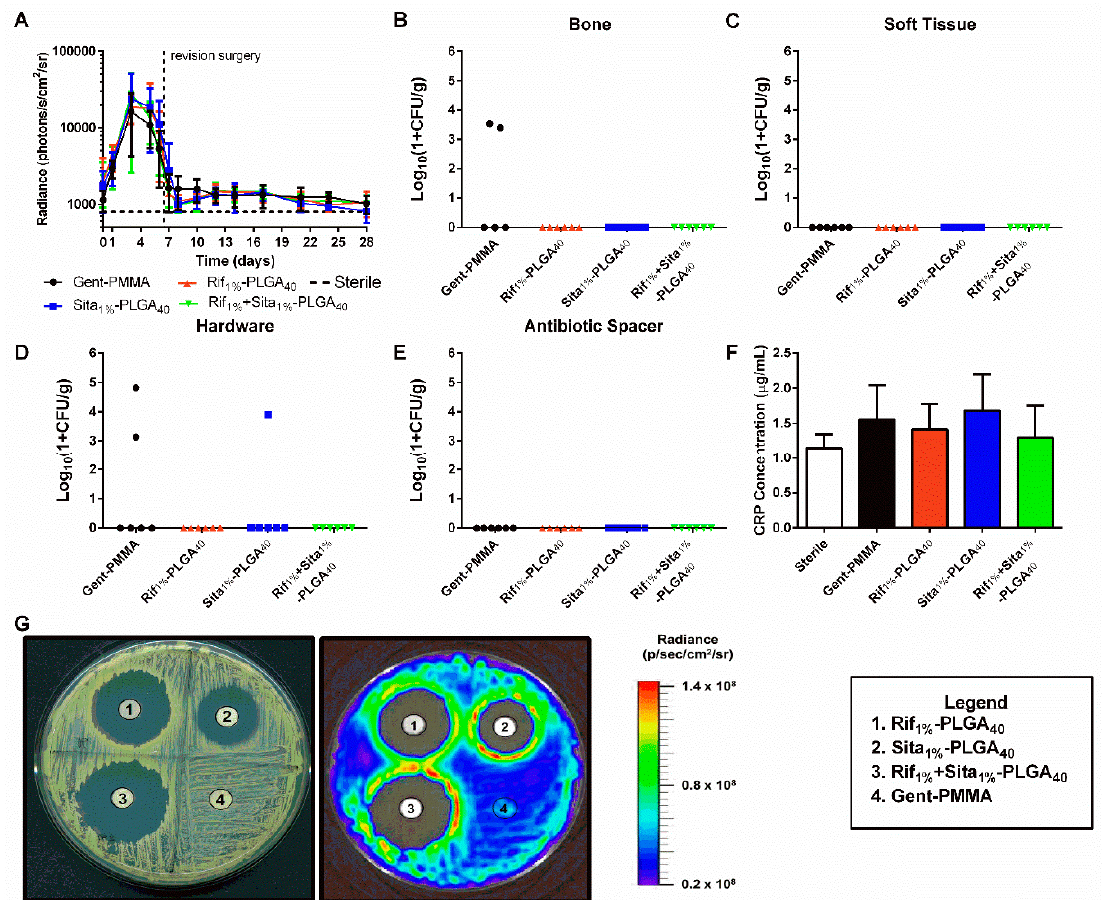
Figure 4. Quantitative assessment of implant-associated osteomyelitis yielded no significant differences between any of the four treatment groups 3 weeks post-revision. ( a ) In vivo longitudinal bioluminescence measurements yielded no differences in bacterial burden between any of the four groups. ( b – e ) This is further illustrated by the quantification of bacterial colonization in bone, soft tissue, hardware, and antibiotic spacer 21 days post-revision surgery. 2/5 bone samples for Gent-PMMA were positive for bacterial colonization, 2/6 hardware samples for Gent-PMMA, and 1/6 samples for Sita 1% -PLGA 40 were positive for bacterial colonization. All other samples were culture negative. Again, no differences were observed. ( f ) C-reactive protein levels were measured by serum collection. No differences were observed for any group. ( g ) Lastly, CaPS harvested 3 weeks post-revision retained bioactive elution of incorporated antibiotics observed by a zone of inhibition, while Gent-PMMA produced no zone of inhibition. All significance was judged for p < 0.05 by 1- and 2-way ANOVA. Bacterial quantification represented as median, all other data was represented as mean ± standard deviation. N = 8 samples/group for BLI, n = 6 samples/group for CFU, and n = 5–8 for CRP quantification.